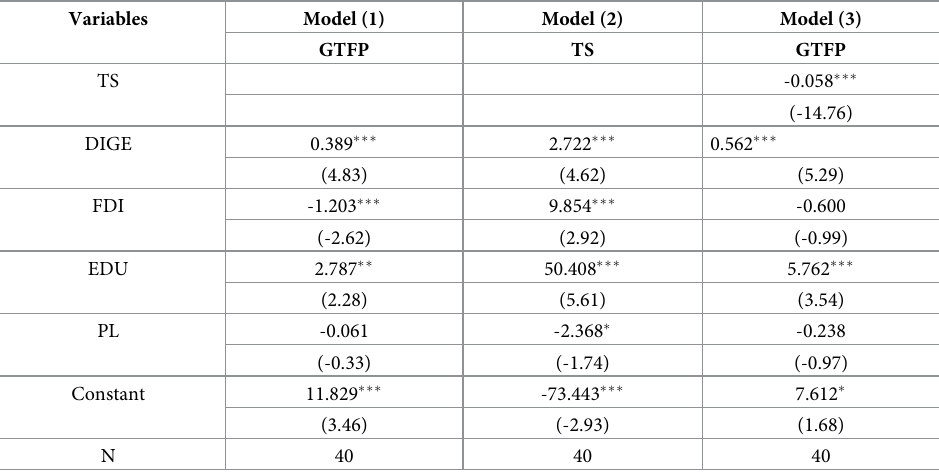
Table 11. Evaluation of the intermediary effect of the industrial structure